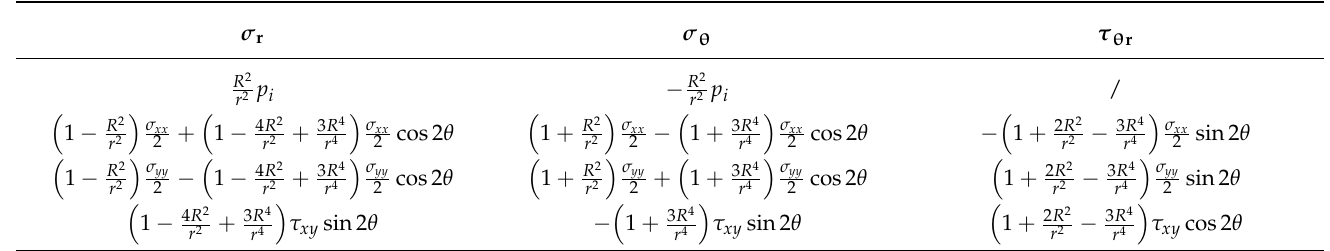
Table 2. Stress distribution expression for the surrounding strata caused by p i, σ xx , σ yy , τ xy , τ xz , and τ yz .